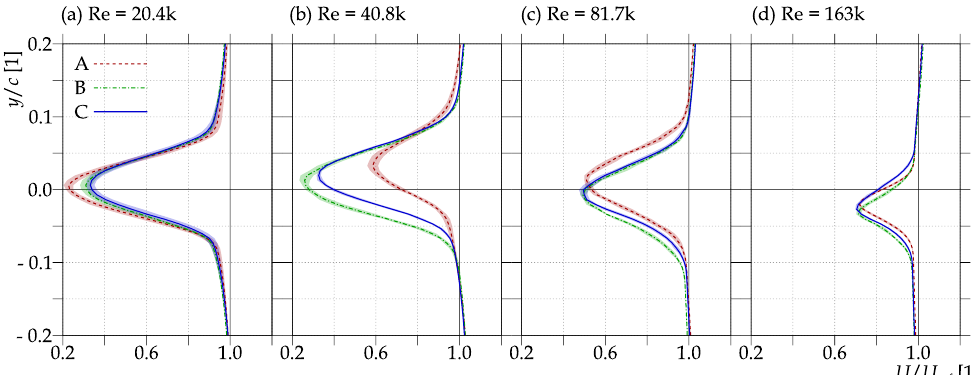
Figure 5. The cross-stream profile of average stream-wise velocity (cid:104) u (cid:105) at stream-wise distance 10mm = 1/8 c past the trailing edge. Angle of attack α = 0 ◦ in all panels. The uncertainty is displayed via the